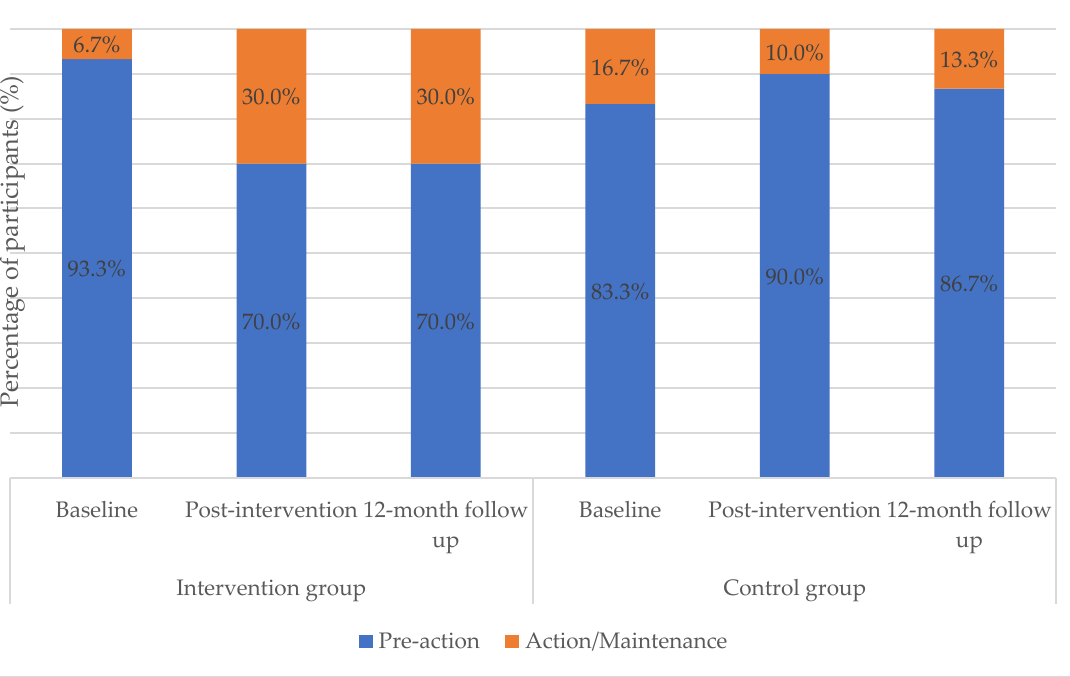
Figure 3. Evolution in the stages of change according to assignment group ( n = 60).